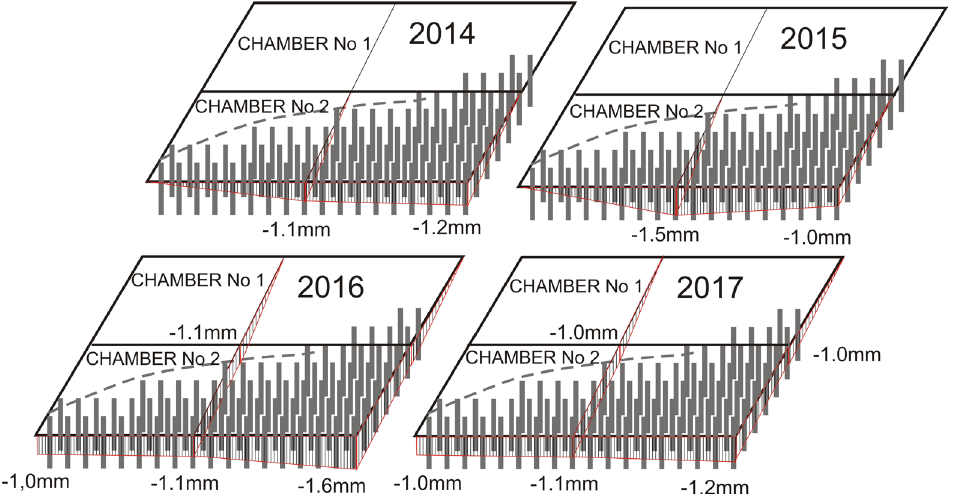
Figure 14: Displacement of controlled